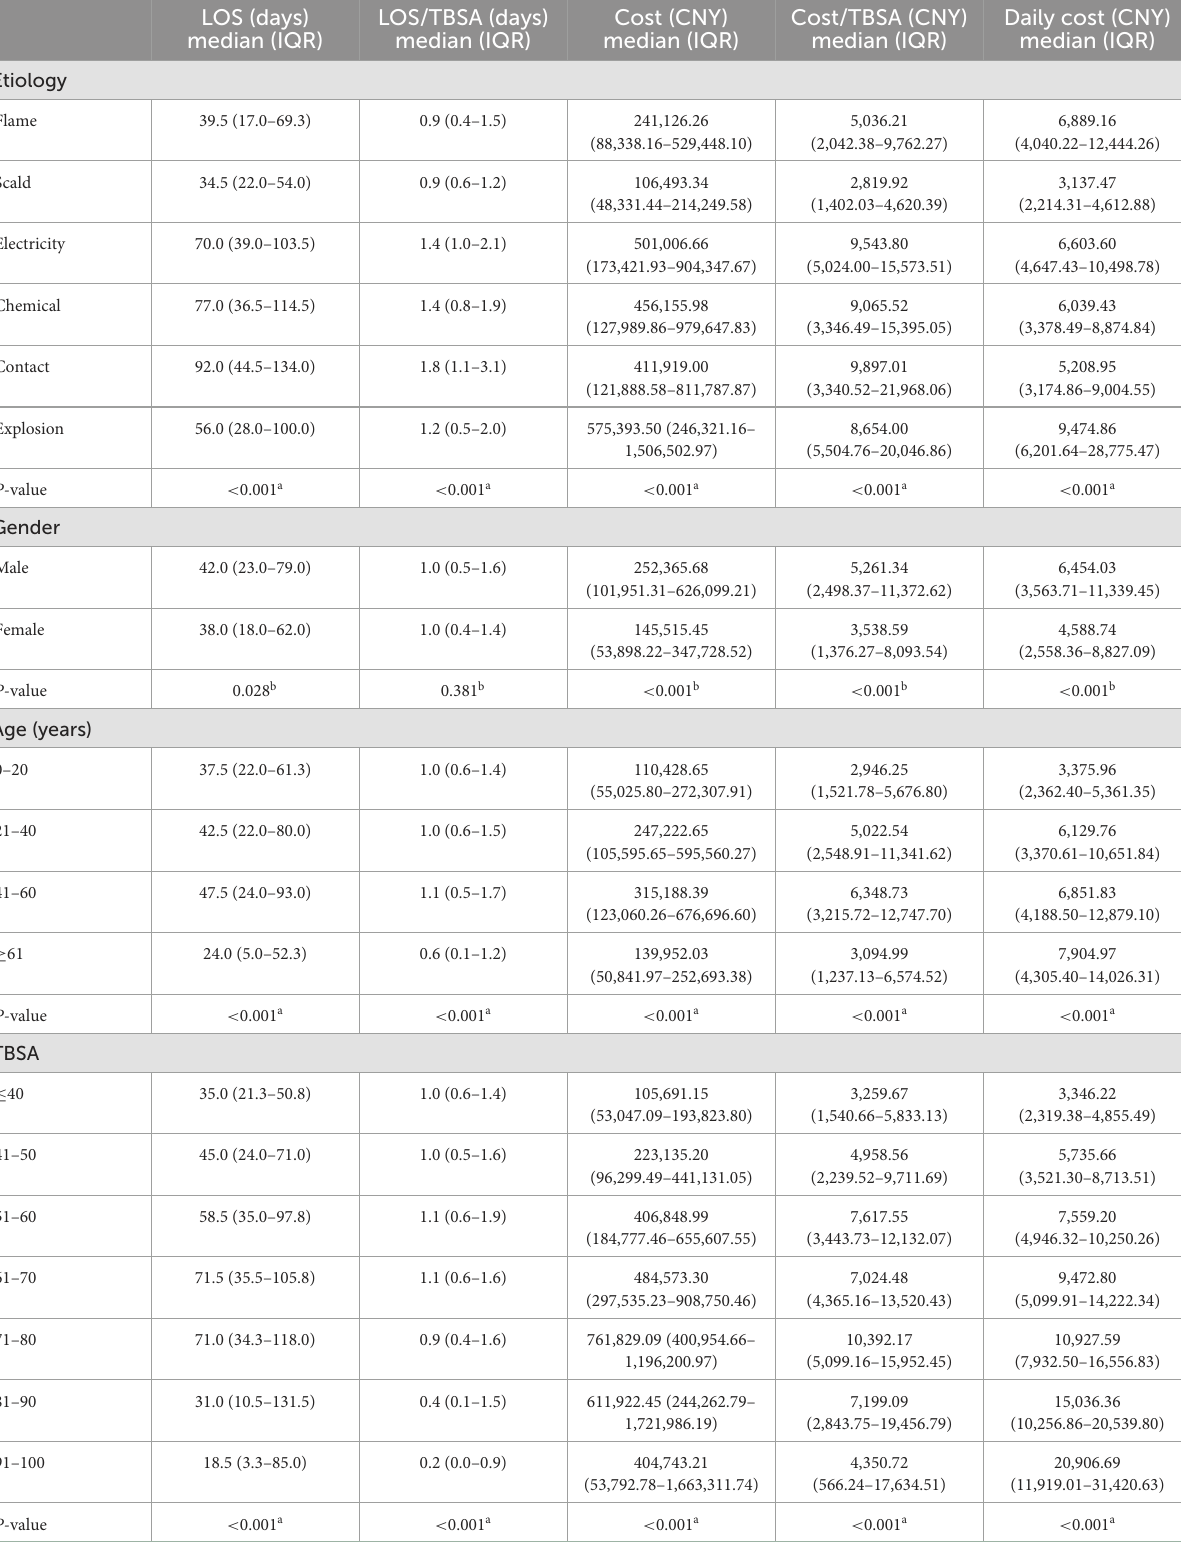
TABLE 4 Analysis of LOS and cost, classified by TBSA, etiology, age, gender, full-thickness, burns surgery numbers and